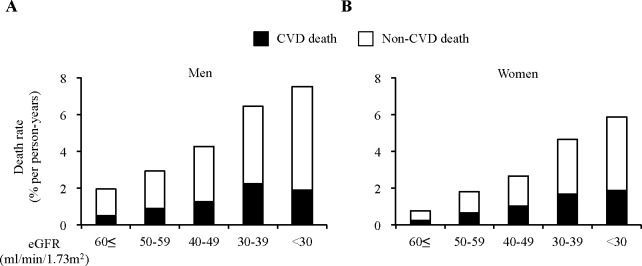
Distributions of cardiovascular disease (CVD) and non-CVD mortality rates according to estimated glomerular filtration rate (eGFR) in Japanese men and women.Distributions of CVD deaths and non-CVD deaths in men (A) and in women (B) were categorized according to eGFR in increments of 10 ml/min/1.73 m2.